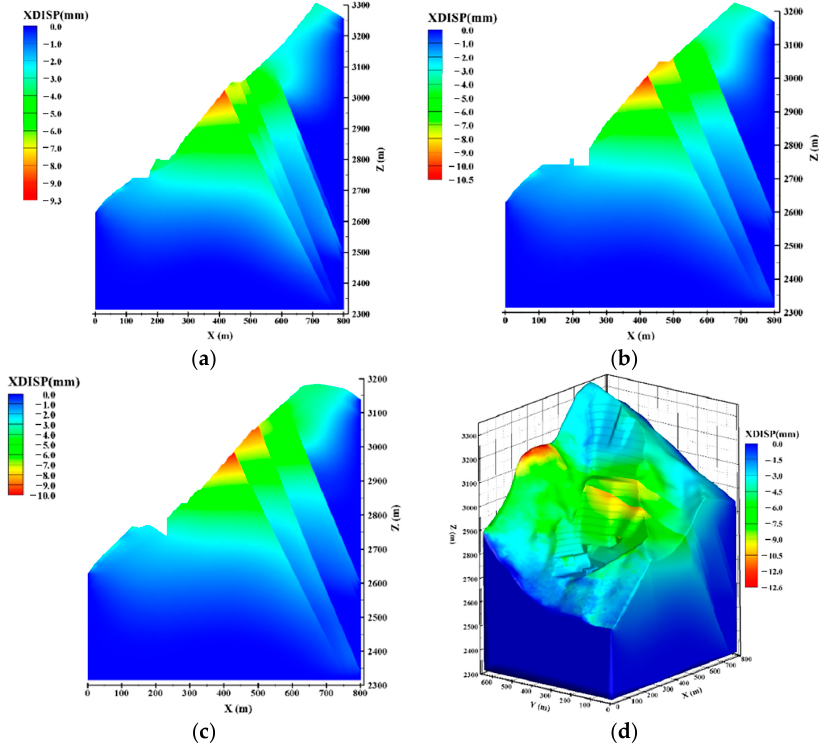
Figure 6. Transverse riverward displacement distribution of slope under condition I. ( a ) Profile 5; ( b ) profile 10; ( c ) profile 13; ( d ) entire body.